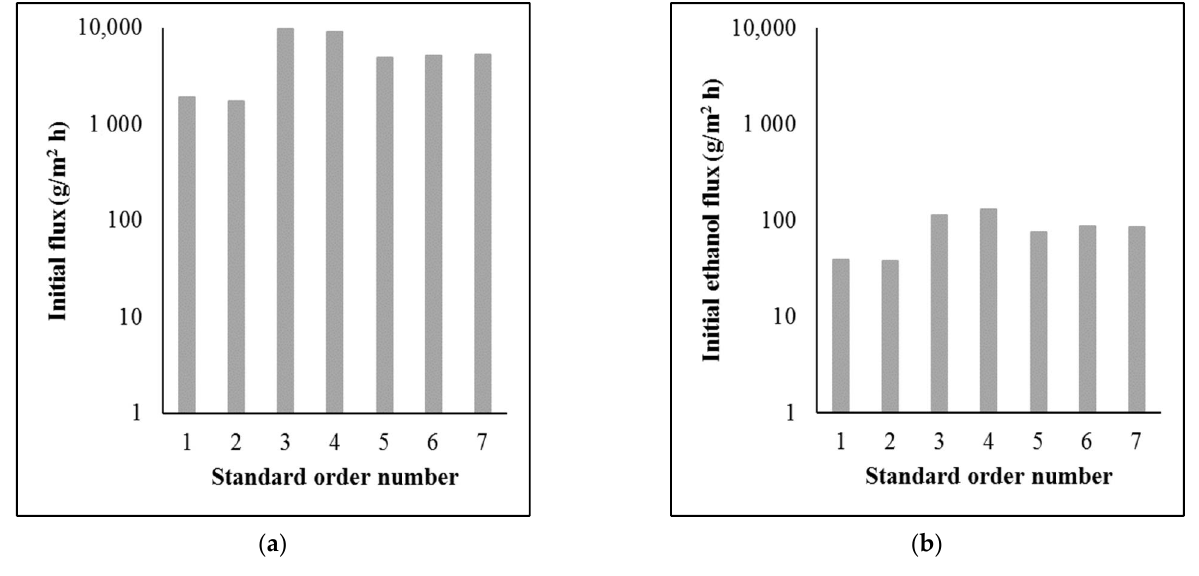
Figure 3. Hydrodynamic parameters of the separations: ( a ) initial flux (log); ( b ) initial ethanol flux (log).